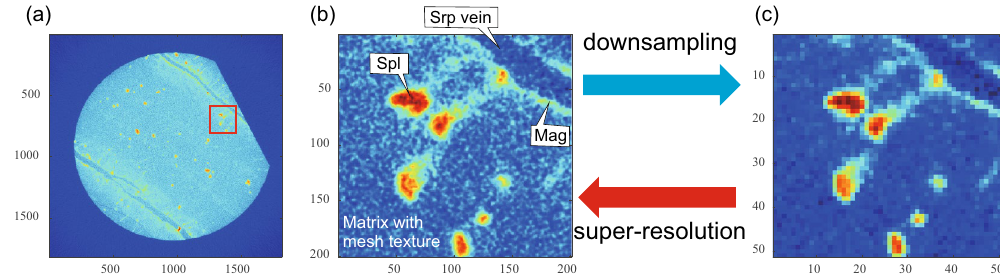
Figure 1. ( a ) X-ray CT images of the serpentinized dunite obtained by a medical CT scanner at Chikyu . The area of the patch area is indicated by the red square. ( b ) High resolution X-ray patch image of CM1A. Srp serpentine, Spl spinel, Mag magnetite. ( c ) Artificially created low-resolution X-ray patch image. Voxel size of the high-resolution image was 10 µ m